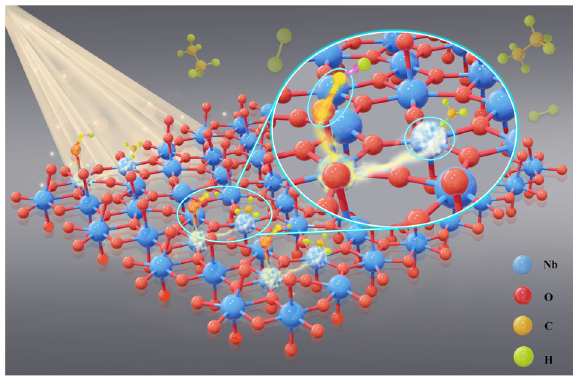
Fig. 6 | Schematic diagram of Photocatalytic NOCM mechanism. Photoexcita- tion causes electron transfer from LA to LB site, which enhances the intensity of LA andLBsites,facilitatingthepolarizationofmethaneandtheactivationofC – Hbond. The colors of Nb, O, C, and H atoms are blue, red, yellow, and green,